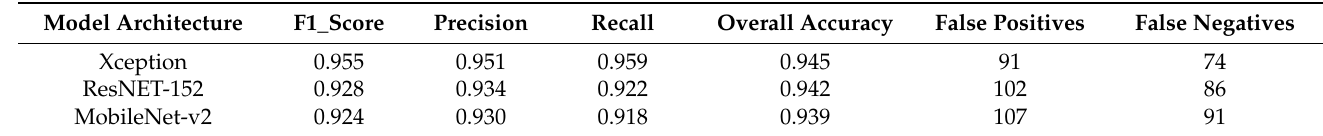
Table 6. Xception comparative performance against MobileNet-v2 and ResNet